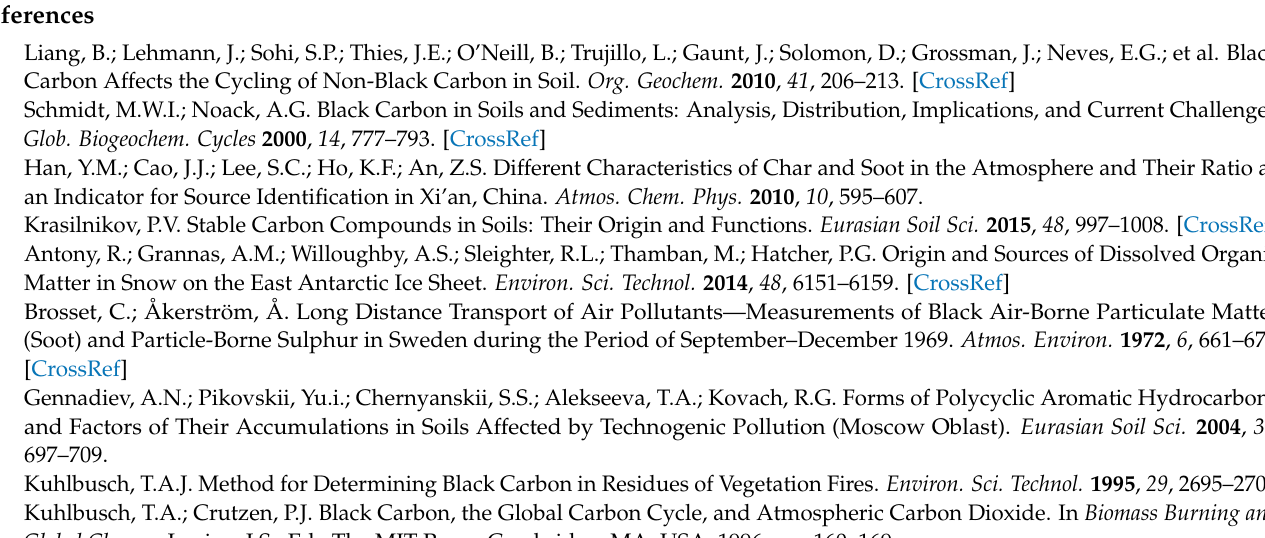
class texture. Red—muck samples, green—sand, light blue—sandy loam, dark blue—loamy sand (according to USDA classification); Figure S3. First derivative of mean spectra for the three classes of the PLS-SVM classifier. The three classes of BC content are represented by low (0–0.7 g kg − 1 ) in the orange line: medium (0.71–2.0 g kg − 1 ) in the brown line and: high (>2.01 g kg − 1 ) black line; Figure S4. Enlargement in the visible range of the first derivatives for BC content levels spectra (from Figure S3). The three classes of BC content are represented low (0–0.7 g kg − 1 ) in the orange line: medium (0.71–2.0 g kg − 1 ) brown line and: high (>2.01 g kg − 1 ) black line; Figure S5. Enlargement (from Figure S3) of a NIR region of the first derivatives for BC content levels spectra; Figure S6. Enlargement (from Figure S3) of a NIR region of the first derivatives for BC content levels spectra; Table S1: Summary statistics for the different soil types; Table S2: Summary statistics of soils samples and correlation matrix of soil properties ( n = 40, without 3 muck